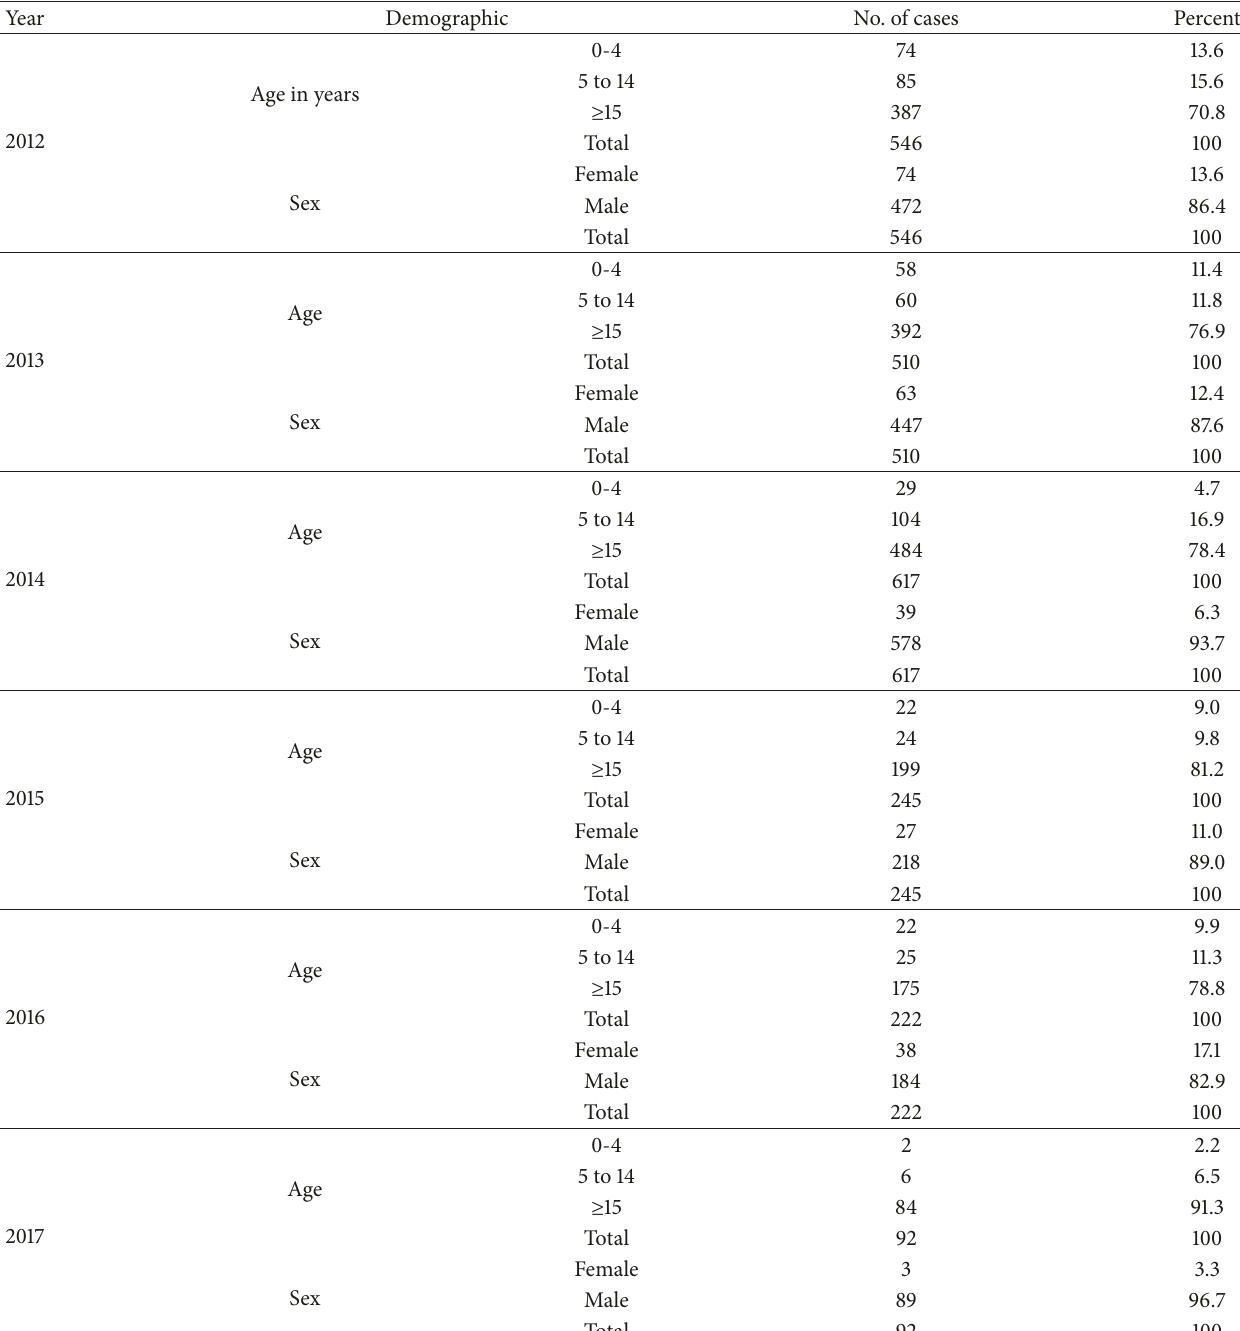
Table 1: Trends of leishmaniasis in relation to age and